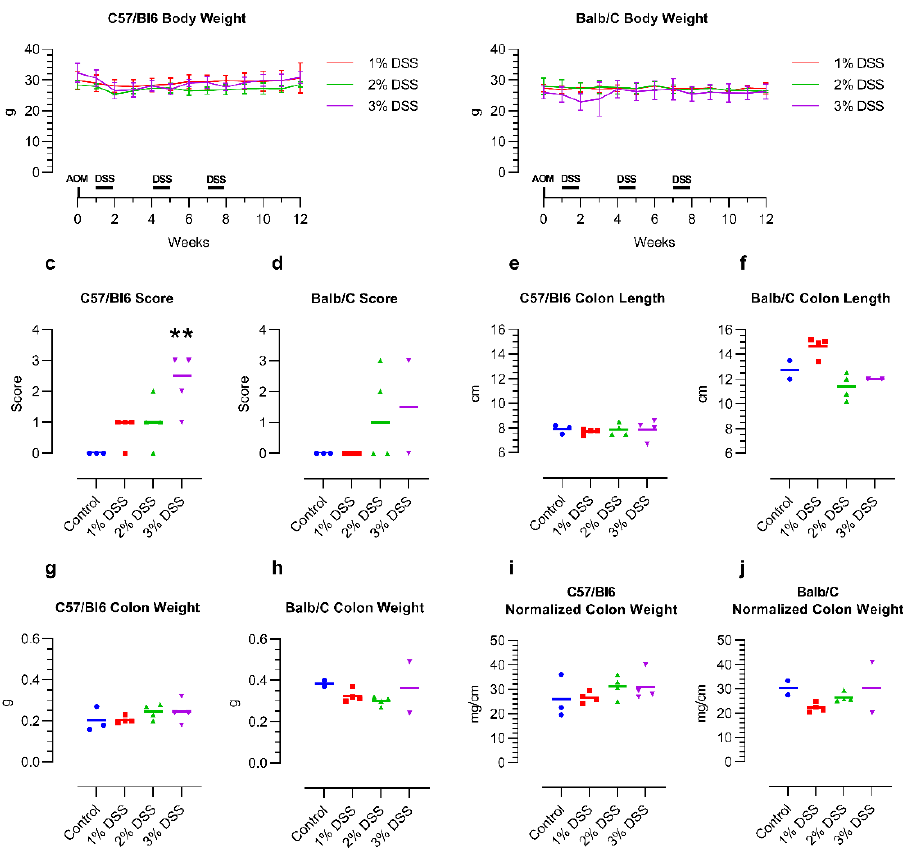
Figure 1. Effect of DSS treatment on body weight ( a , b ), histology score ( c , d ) and colon macroscopic parameters ( e – j ) of 14-month-old female C57/Bl6 and Balb/C mice with CAC induced by 3 different concentrations of DSS. Control = untreated control mice of the same age. n = 2 – 4. Histology score: 0 — no abnormalities, 1 — minimal changes such as aberrant crypt foci, 2 — high-grade dysplasia, 3 — intramucosal carcinoma. ** p < 0.01 Kruskal – Wallis with Dunn post hoc test vs control for C57/Bl6. Statistical correlation analysis is provided in Figure 3.